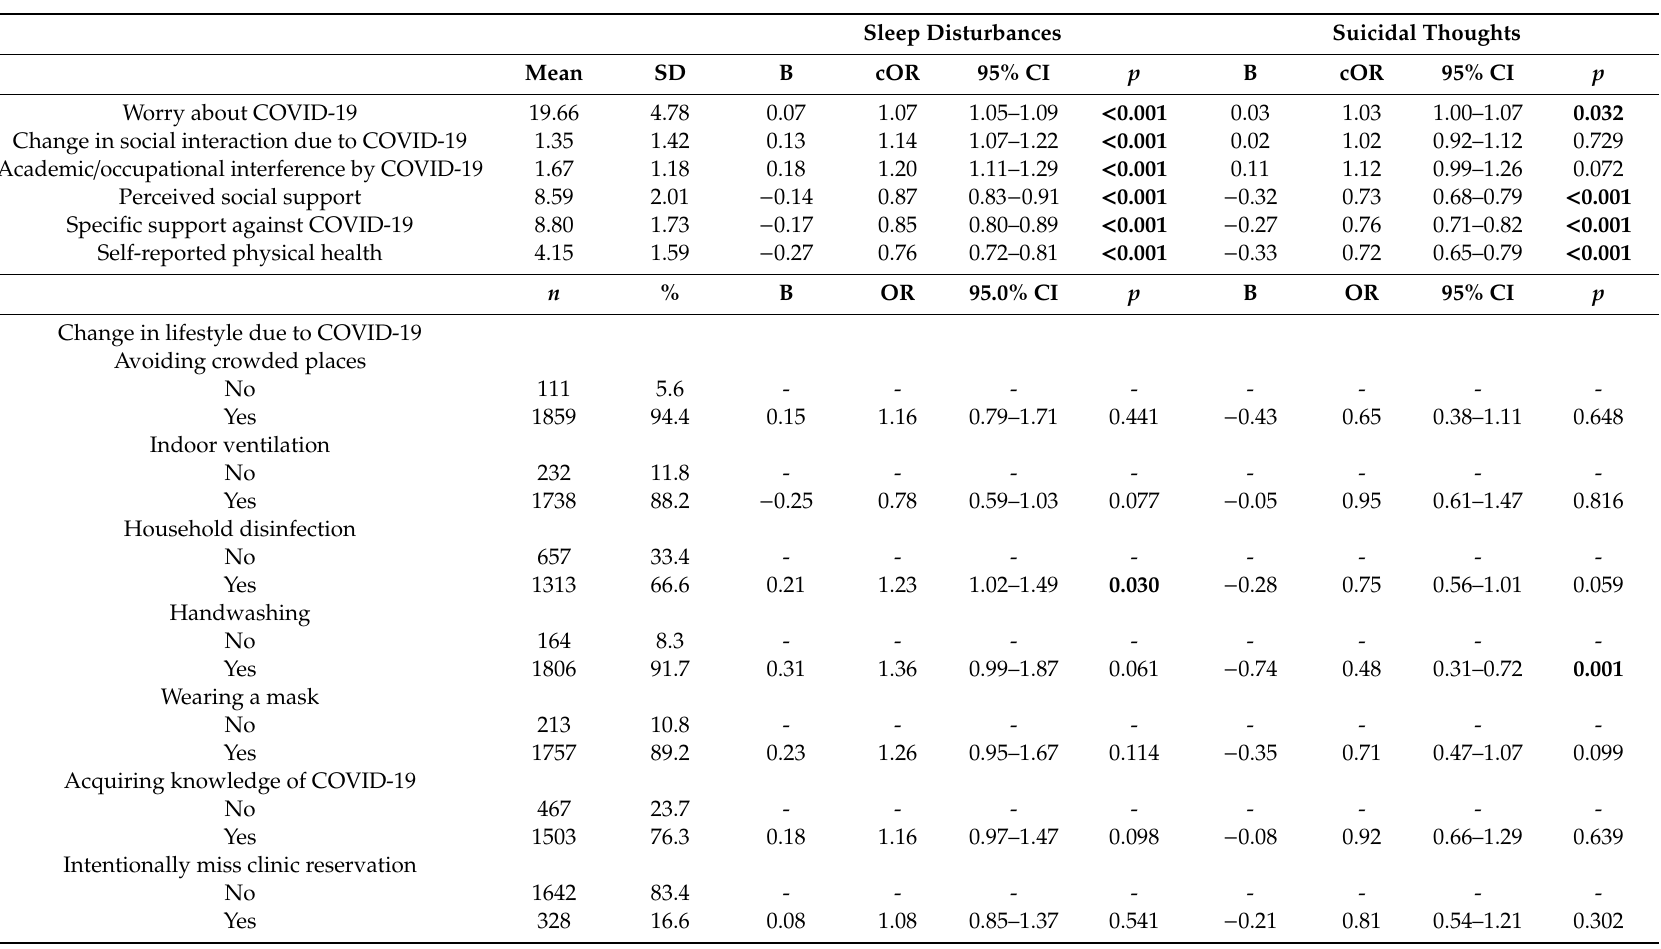
Table 2. COVID-19 related factors associated with sleep disturbance and suicidal thoughts examined by univariate logistic regression ( n = 1970). Sleep Disturbances Suicidal